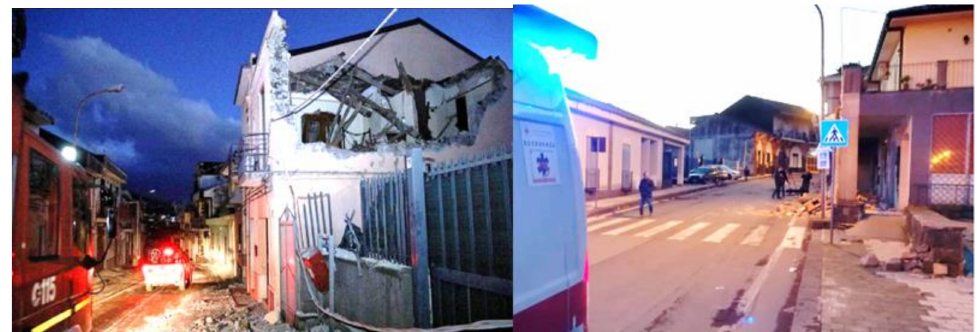
Figure 16. Some examples of images posted on the Twitter platform during the 2018 Italy earthquake in Catania area,